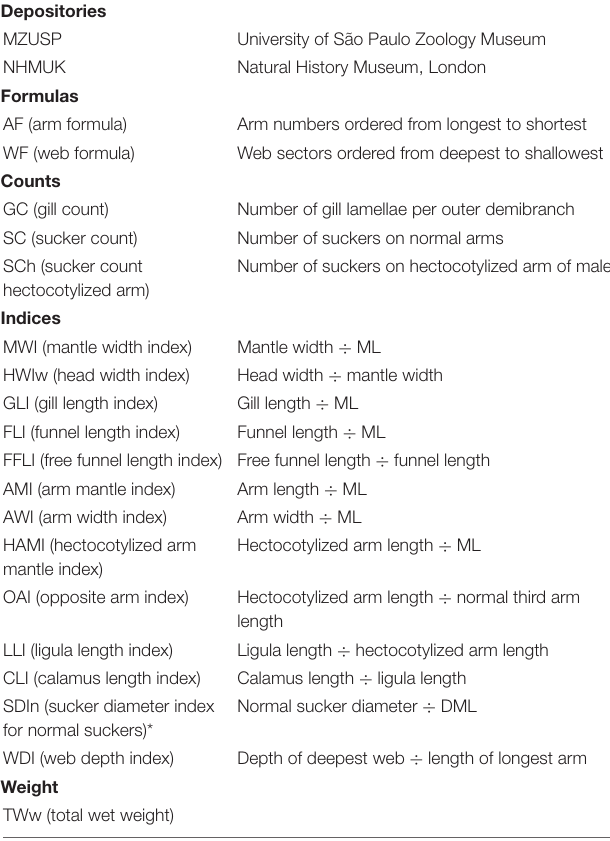
TABLE 2 | Abbreviation for depositories, formulas, counts, indices and weight measurements used in the present